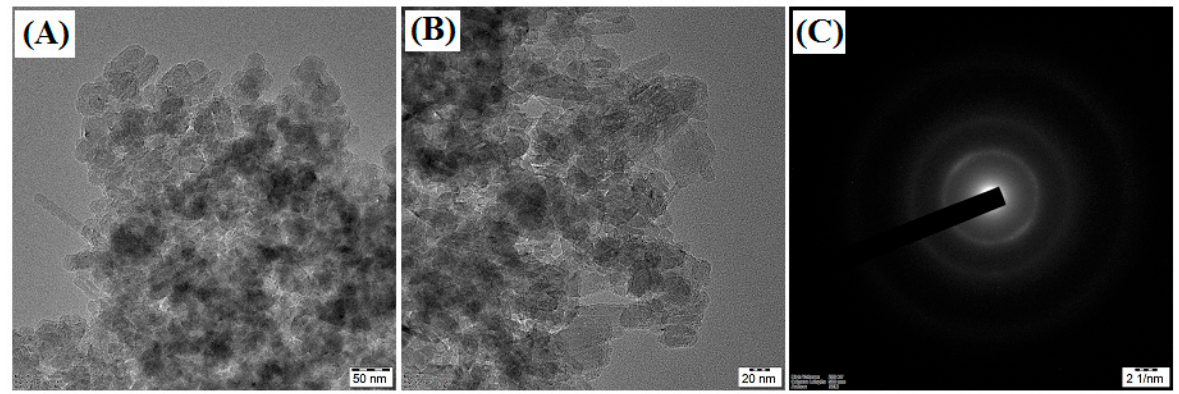
Figure 3. ( A , B ) HRTEM image of CNP/EDTAPEI sorbent at varying resolution illustrates the surface morphology of nanofibers; ( C ) SAED pattern of CNP/EDTAPEI sorbent.